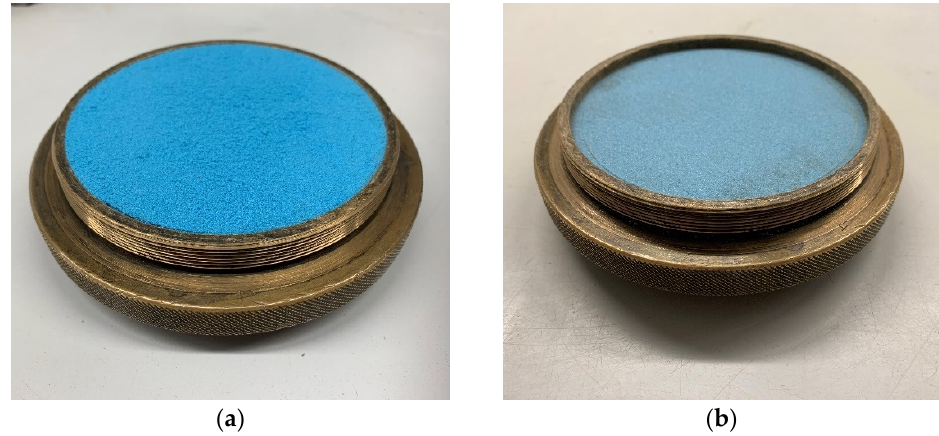
10 of 20 Table 3. Parameters of pycnometry tests. Sample